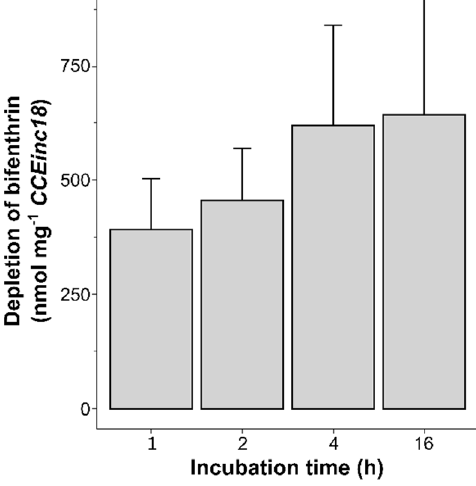
Figure 4. Bar chart showing the amount of metabolized bifenthrin by the recombinantly expressed MR-VL CCEinc18 after 1, 2, 4 and 16 h of incubation.